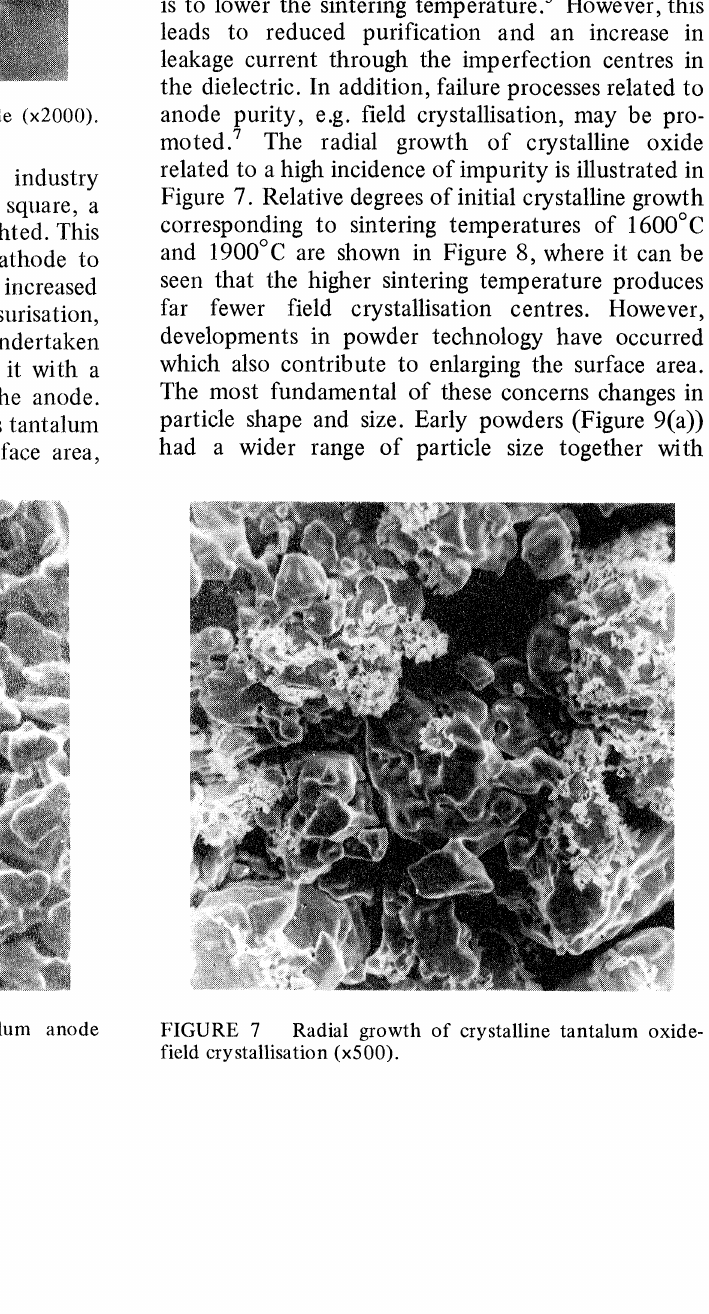
FIGURE 7 Radial growth of crystalline tantalum oxide- field crystallisation